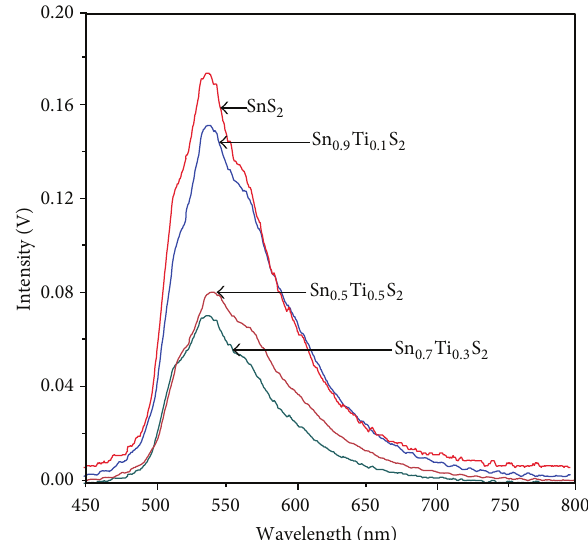
Figure 5: PL spectra of the as-synthesized SnS 2 and Sn 1−